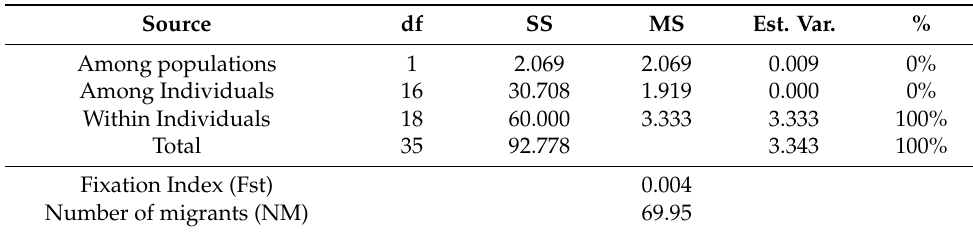
Table 7. Analysis of molecular variance (AMOVA).